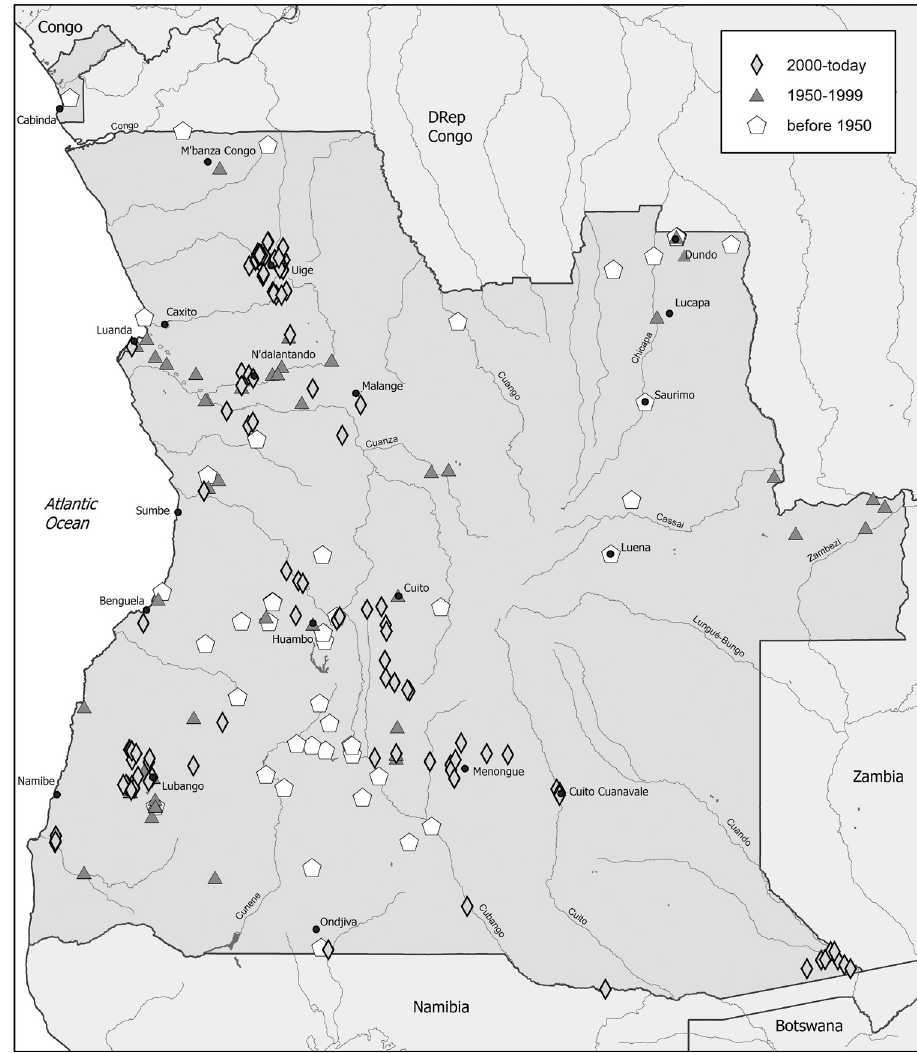
Figure 1. Records of Odonata from Angola before 1950, before 2000 and up to 2016.